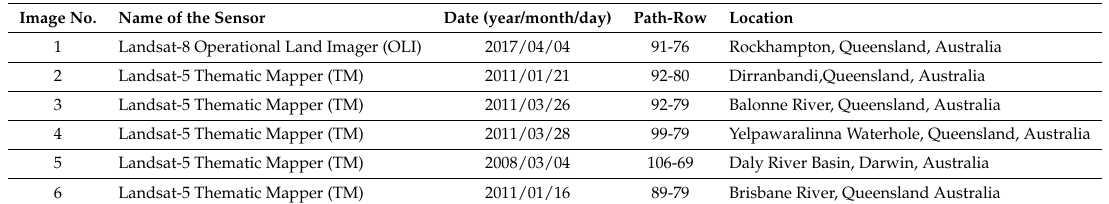
Table 4. Details of Test